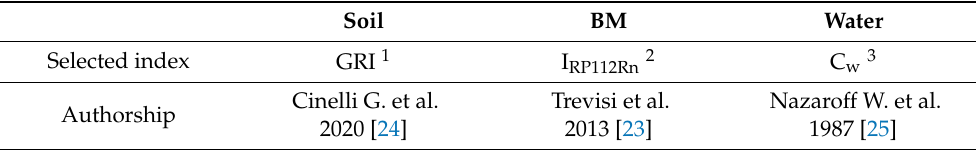
Table 1. Assessment of predictability and probability. Selection of the main indexes, from the literature, for each source (water, building materials (BM), soil).